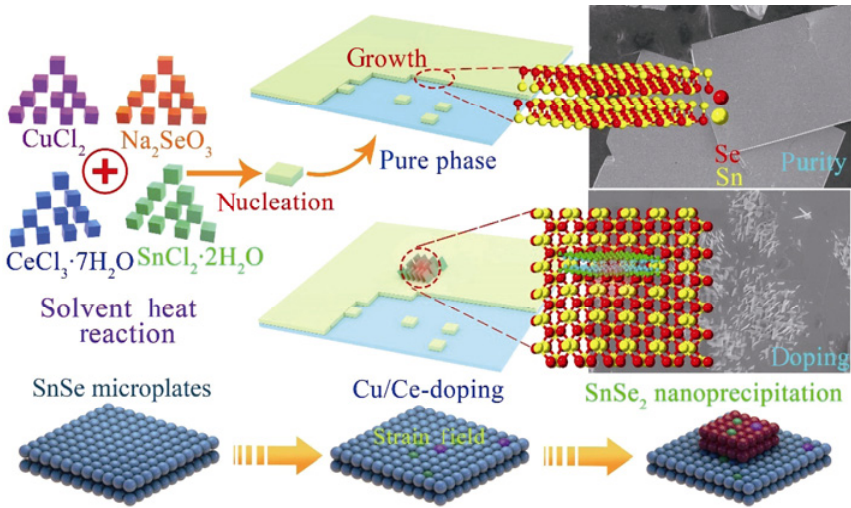
Fig. 5 Schematic representation of formation mechanisms of pure SnSe and Cu and Ce co-doped SnSe.